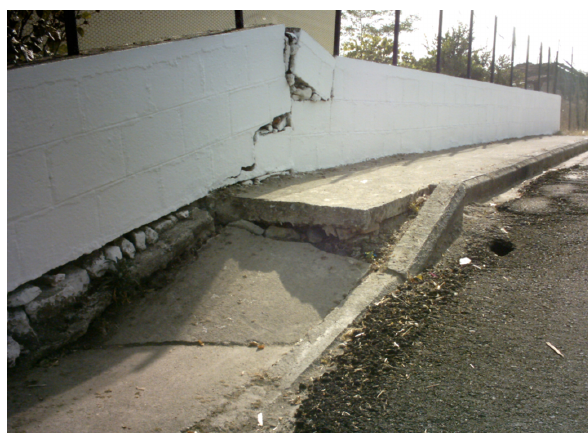
Figure 5. Intensive surface deformations occurring at the Niki Vil- lage, at the East Thessaly